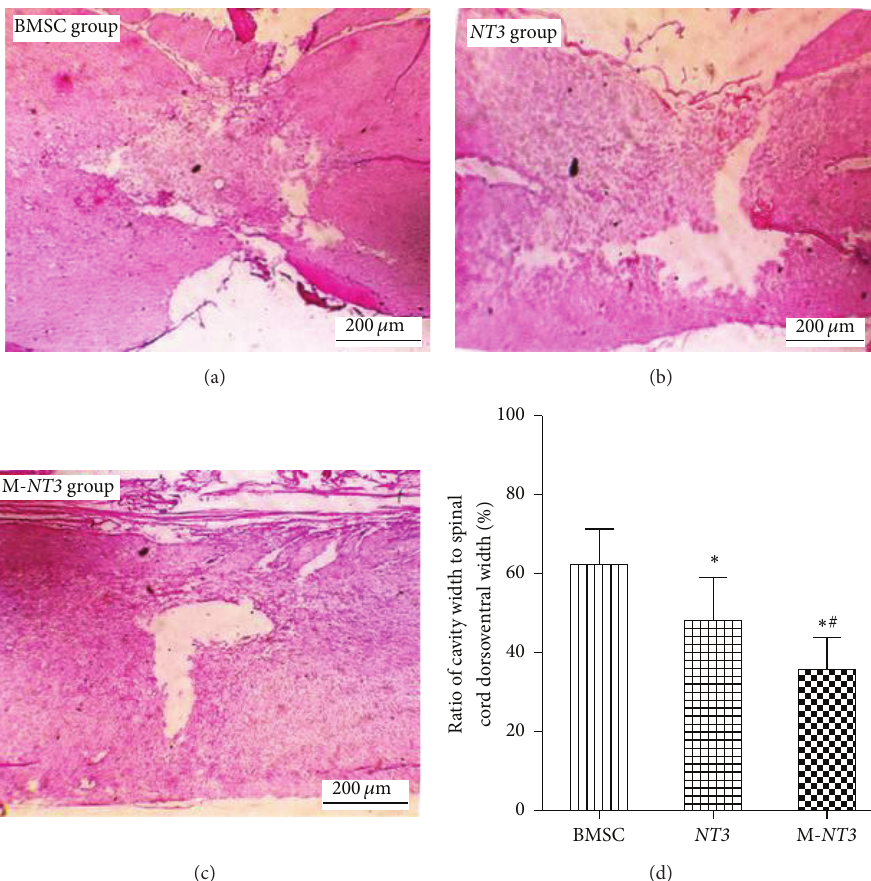
Figure 6: The cystic cavity area of the injured spinal cords on day 35 after cell transplantation in the BMSC group (a), NT3 group (b), and M- NT3 group (c). Magnification, × 40 ((a), (b), and (c)). Scale bar, 200 𝜇 m ((a), (b), and (c)). The data, which are presented as the means ± SD ( 𝑛 = 12 ), were analyzed using one-way ANOVA. ∗ 𝑝 < 0.05 versus the BMSC group, # 𝑝 < 0.05 versus the NT3 group.